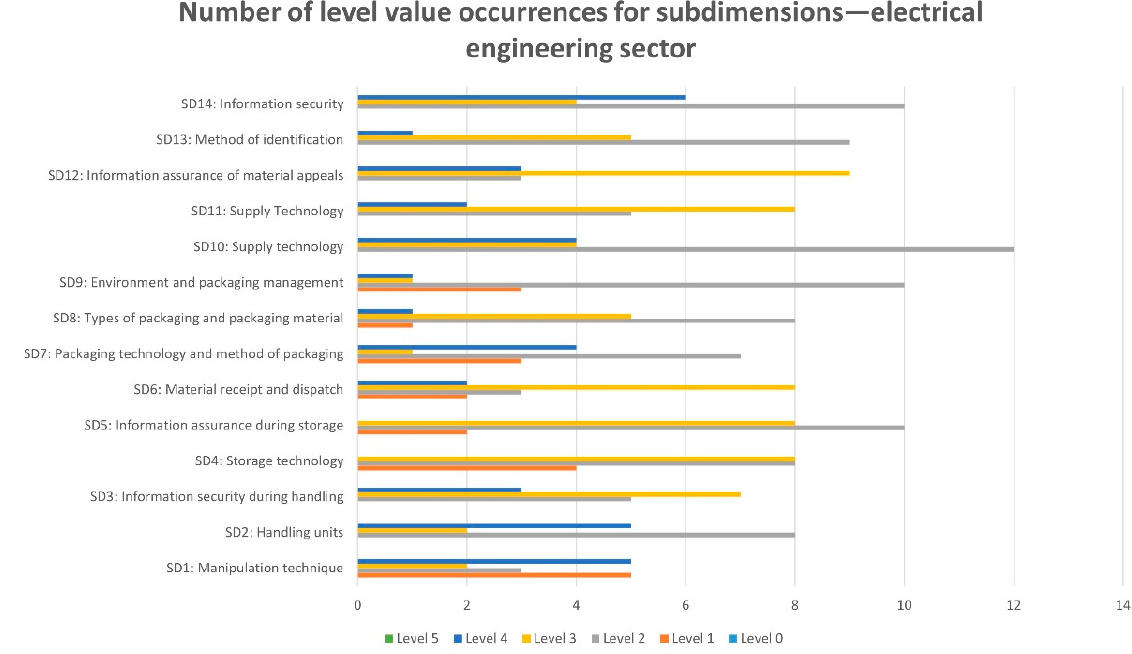
Figure 15. Number of occurrences of level values—electrical engineering.